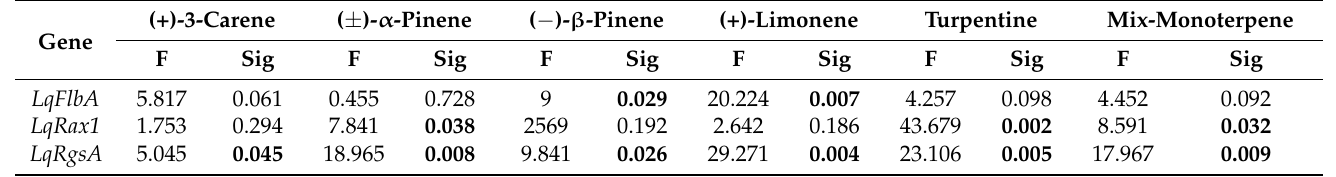
Table 6. Statistics significant of RGSs expression from L. qinlingensis in different